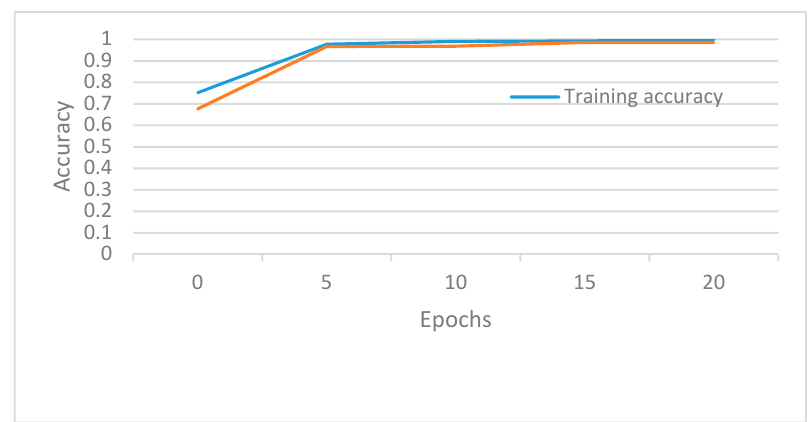
Figure 4. Model accuracy chart, where the blue line represents the training accuracy, while the orange one represents the validation (testing) accuracy.